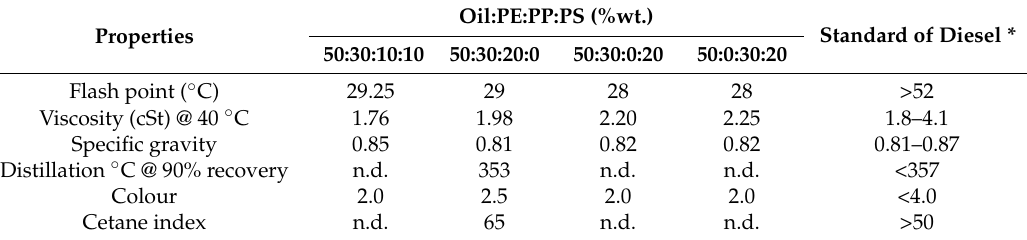
Table 3. Properties and product yields of pyrolytic oil for the waste oil blended with mixed plastic waste (lab-scale).